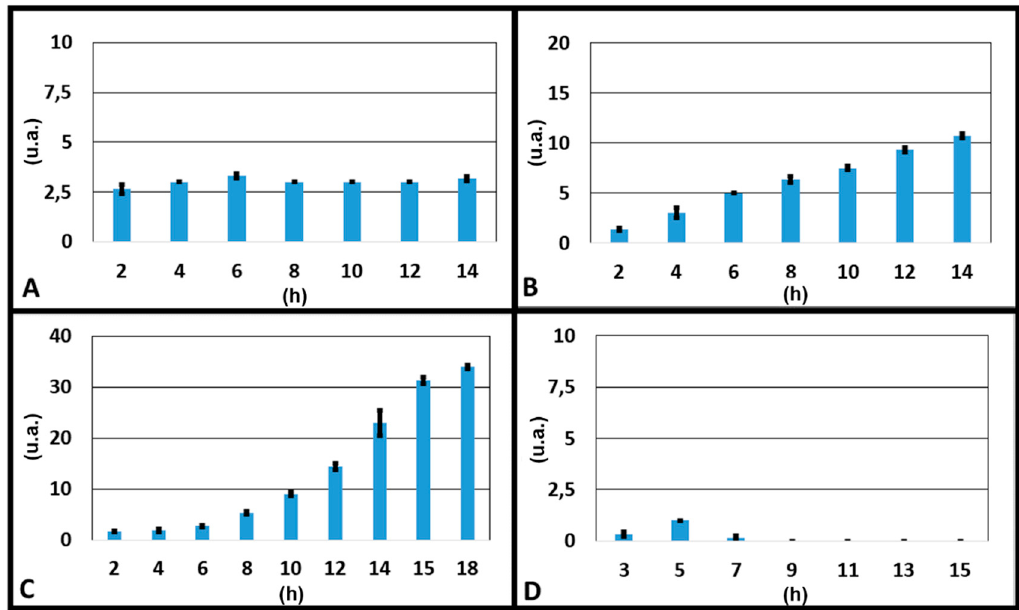
Figure 5. Graphs of the gradients as a function of time obtained during the experiments with dyes in which: ( A ) 3000 µ L of water + dye and 3500 µ L of only water were loaded respectively in the two source reservoirs; ( B ) 3500 µ L of water + dye and 3500 µ L of only water were loaded respectively in the two source reservoirs; ( C ) 3750 µ L of water + dye and 3500 µ L of only water were loaded respectively in the two source reservoirs; ( D ) 3961 µ L of water + dye and 3500 µ L of only water were loaded respectively in the two source reservoirs.